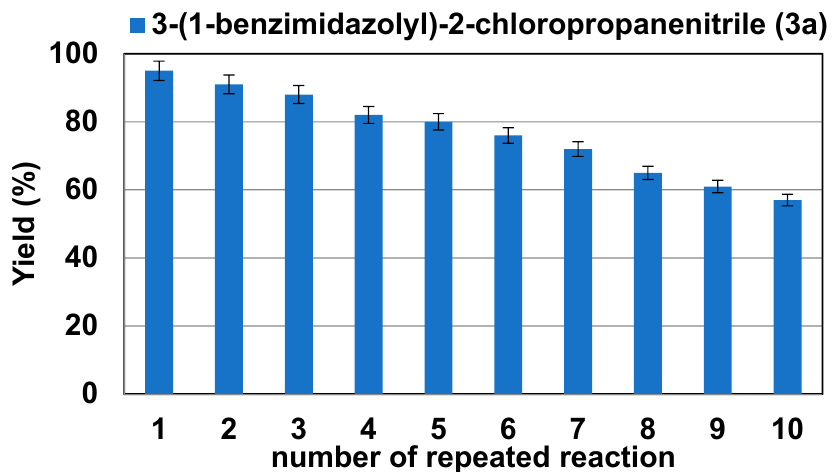
Figure 5. The influence of number of repeated reaction on the synthesis of N-substituted benzimidazole derivatives catalyzed by lipase TL IM from Thermomyces lanuginosus in continuous-flow microreactors.